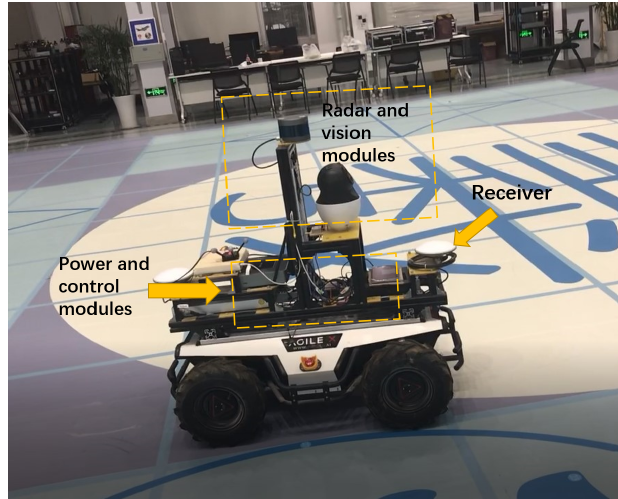
Figure 10. Multi-sensor fusion vehicle.